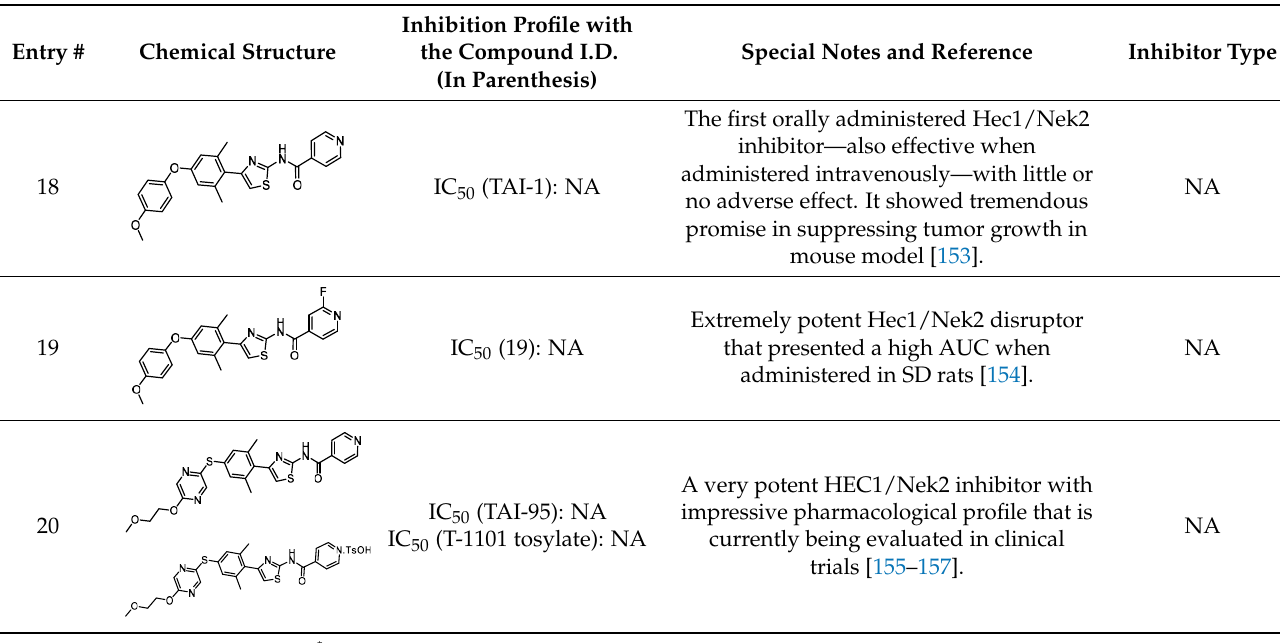
5.Global Proteomic and Phosphoproteomic Data and Activation of the Nek2 Kinase in